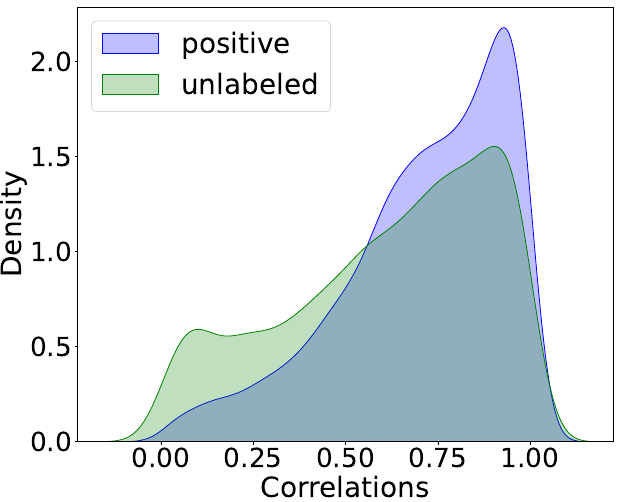
Figure 6. Density plots for correlations for positive and unlabeled interactions Next, we chose the recall accuracy measure to display the performance of all